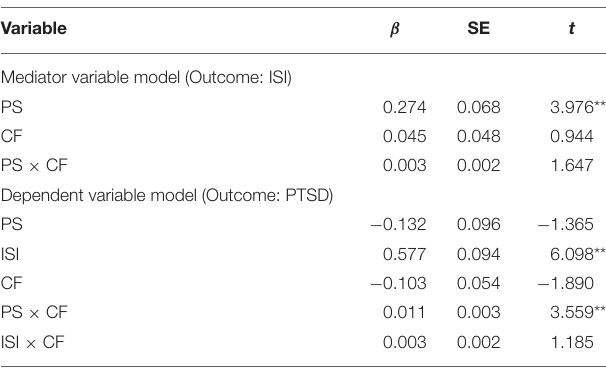
TABLE 4 | Testing the moderated mediation effect of